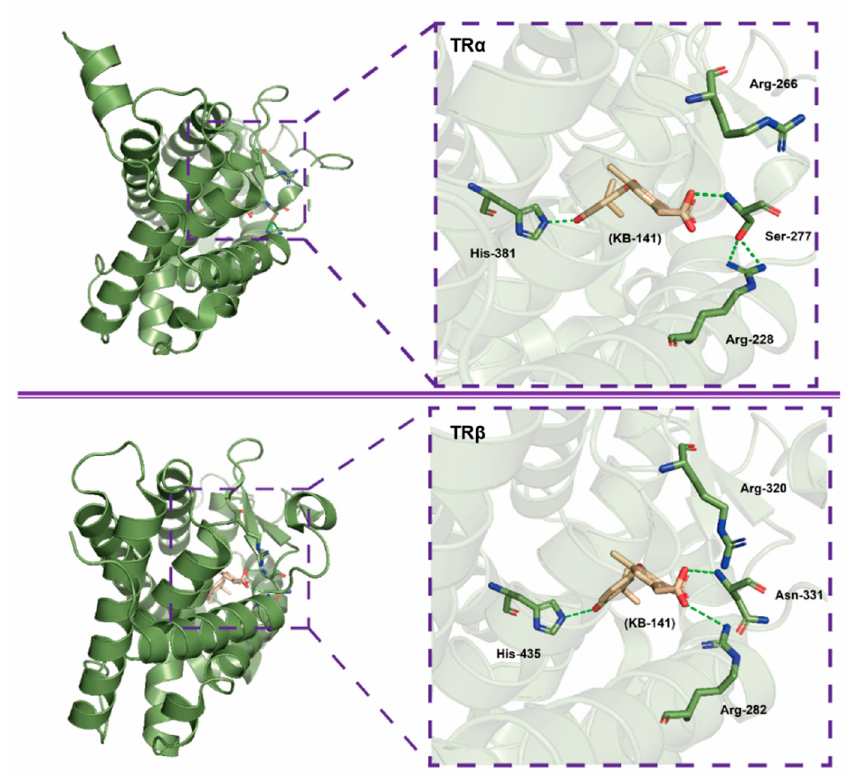
Figure 3. Interaction of the ligand KB-141 with TR α (upper) and TR β (lower) as seen in the crystallo- graphic structures of the LBD/ ligand complexes. Carbon atoms of LBD are depicted as bottle green, oxygen as red, nitrogen as blue, and hydrogen bonding interactions are represented as dashed green lines. PDB code: 1NAV and 1NAX [120].